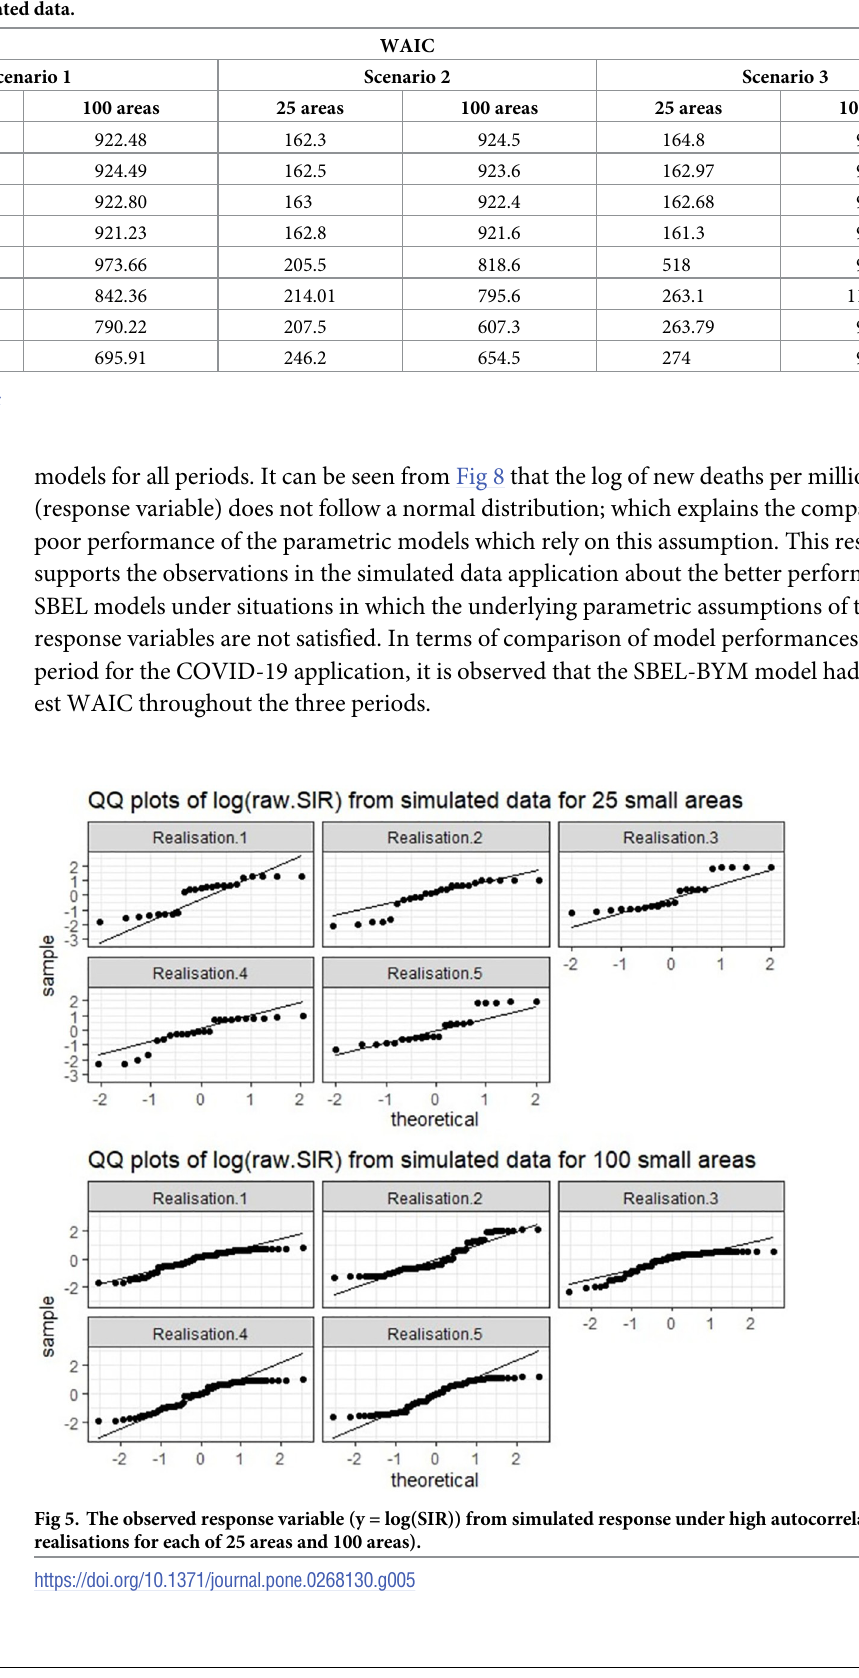
Table 4. Model performance on spatial simulated data.